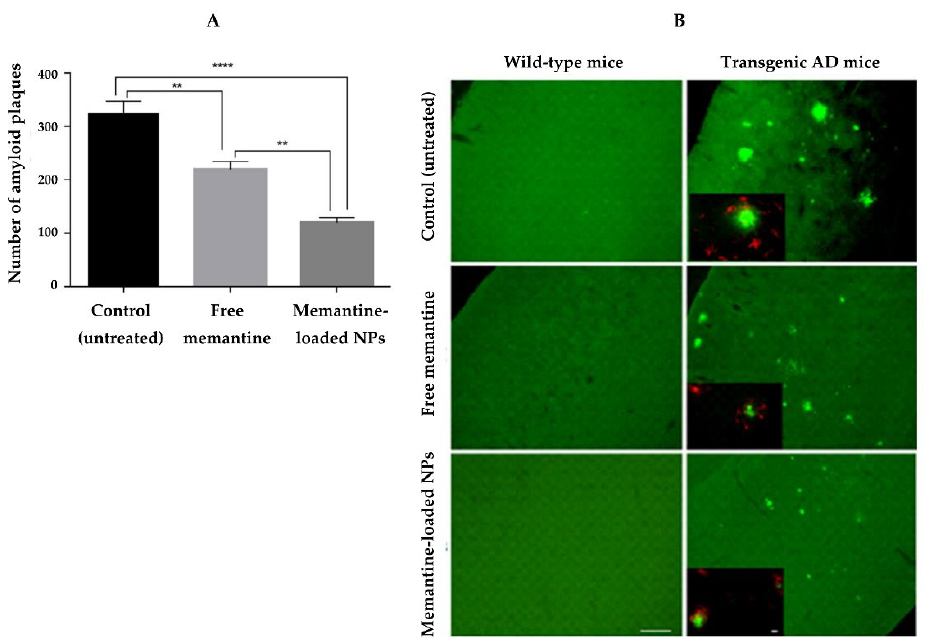
Figure 4. ( A ) Amyloid plaque counting. Data represent mean ± standard deviation. ** and **** Denotes statistically significant differences ( p < 0.01 and p < 0.0001, respectively), and ( B ) immunohistochemical staining of amyloid plaques (green) and a primary antibody (red) of the cortex of wild-type and transgenic AD mice models. Scale bar: 100 µm. Adapted with permission from [78], copyright © 2018, Springer Nature.